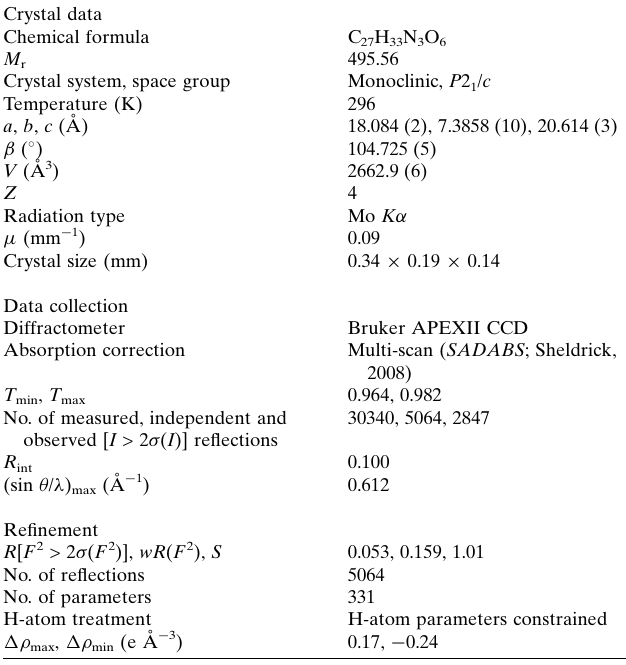
Crystal data Chemical